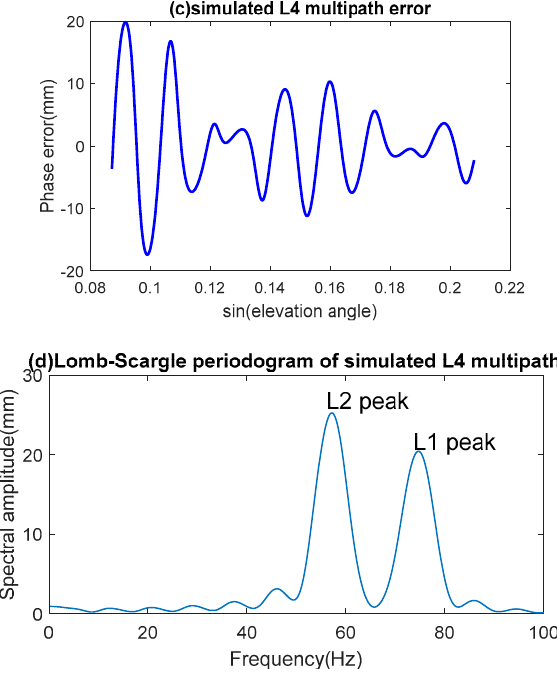
Figure 3. ( a ) Multipath error of double-frequency phase combination; ( b ) Lomb–Scargle Periodogram from satellite PRN30 recorded on 2 and 3 January 2015; ( c ) Simulated double-frequency phase